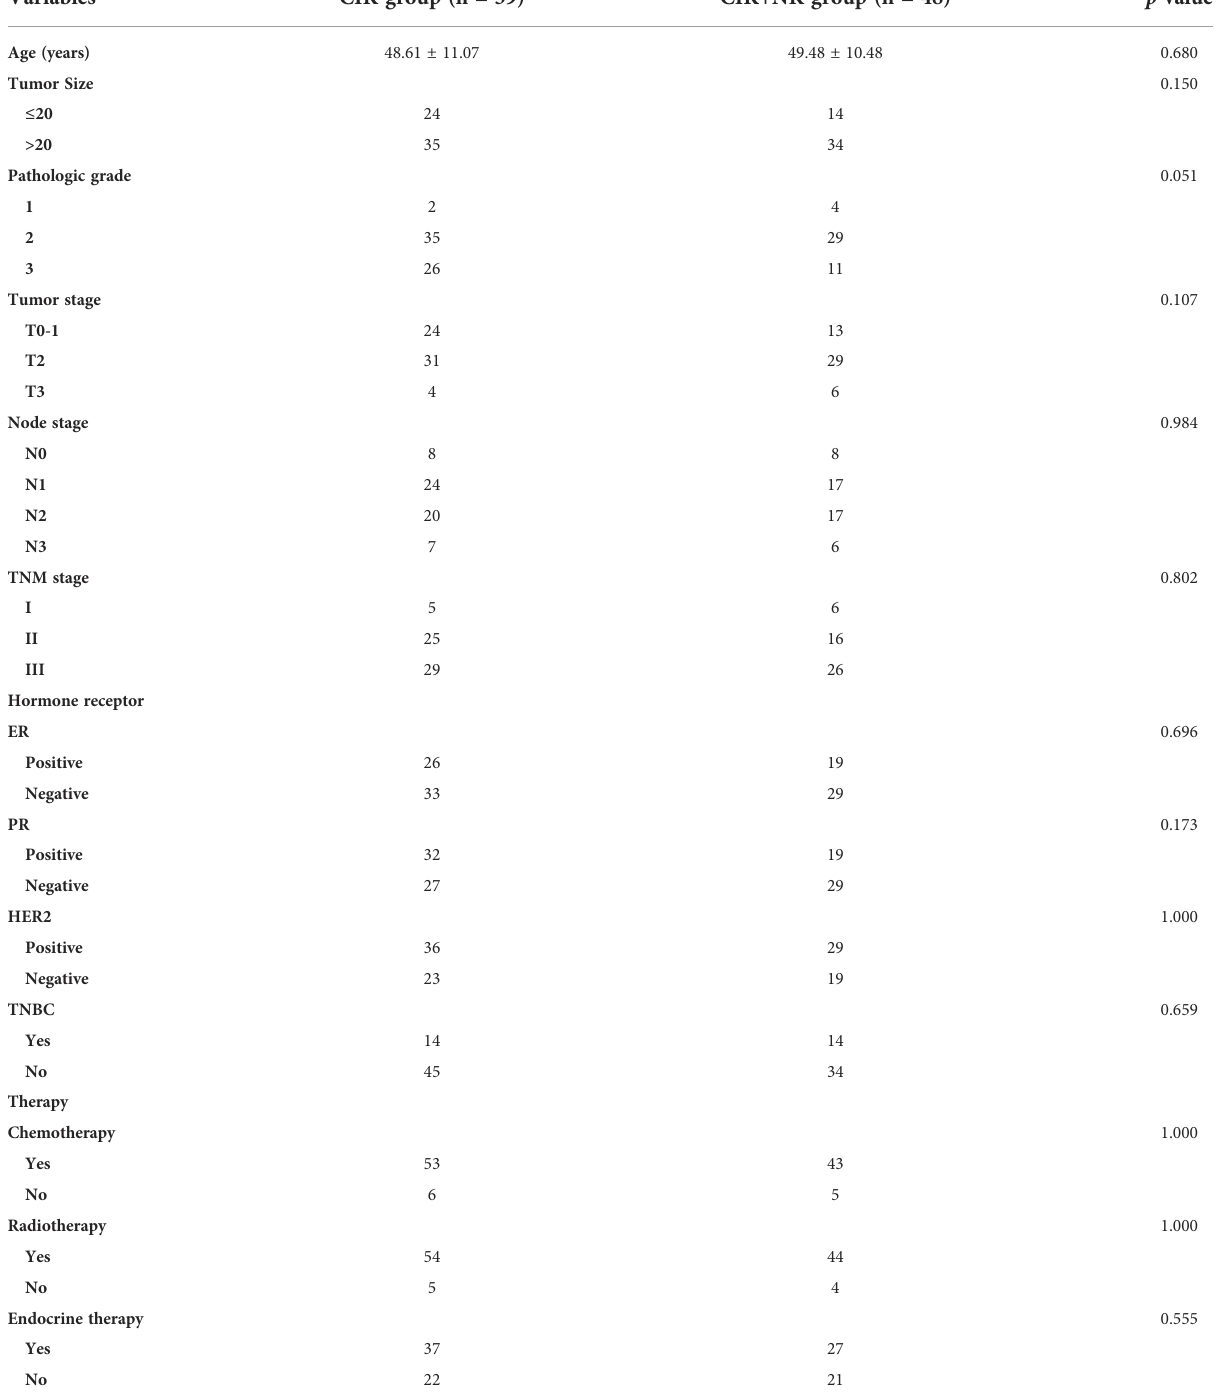
TABLE 2 Demographics and disease characteristics of patients in the CIK immunotherapy treatment group and CIK plus NK cells immunotherapy treatment